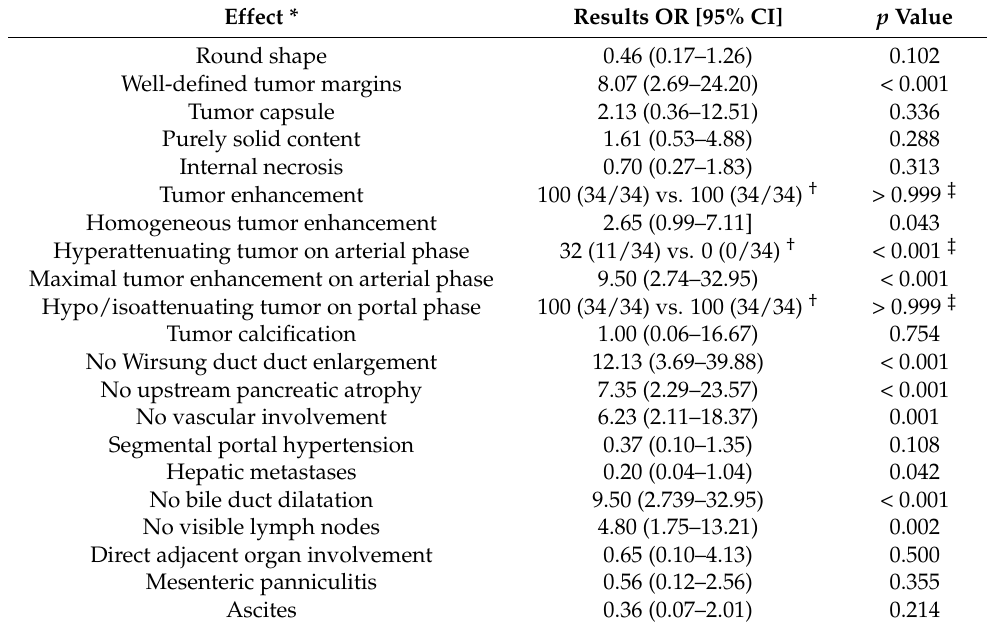
Table 4. Results of univariable analysis with a conditional logistic regression model for 68